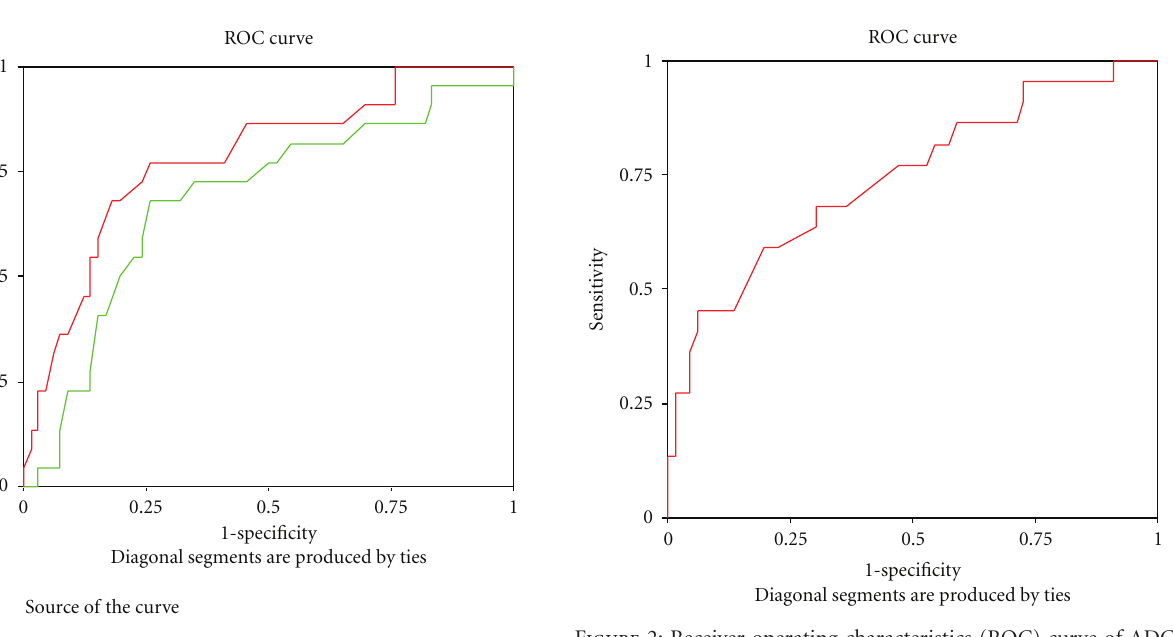
Figure 2: Receiver operating characteristics (ROC) curve of ADC values of central prostatic zones (ADC of central zone: area under the curve: 0.749, P = 0 . 001, 95% confidence interval: 0.623–0.874). Table 1: Correlation between ADC values and Gleason